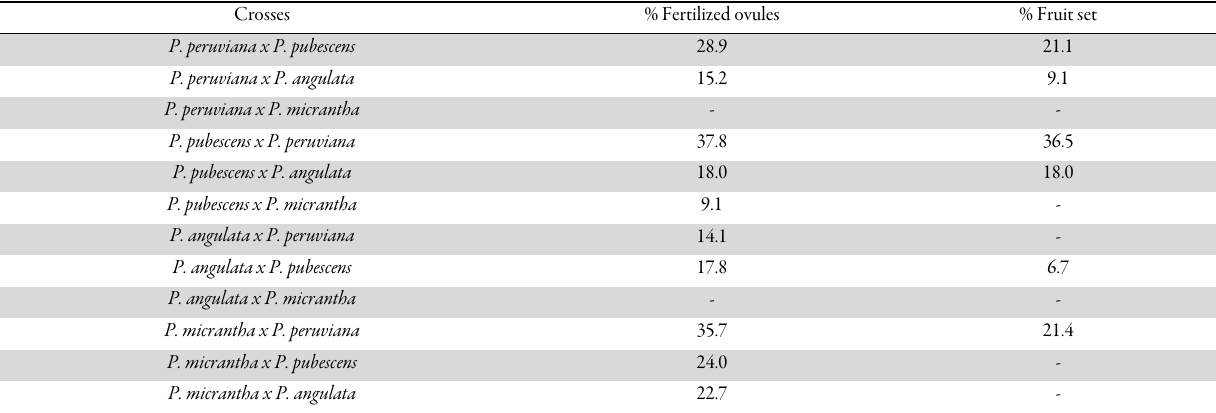
Table 4. Characteristics of the F 1 hybrid plants and its genitors Species